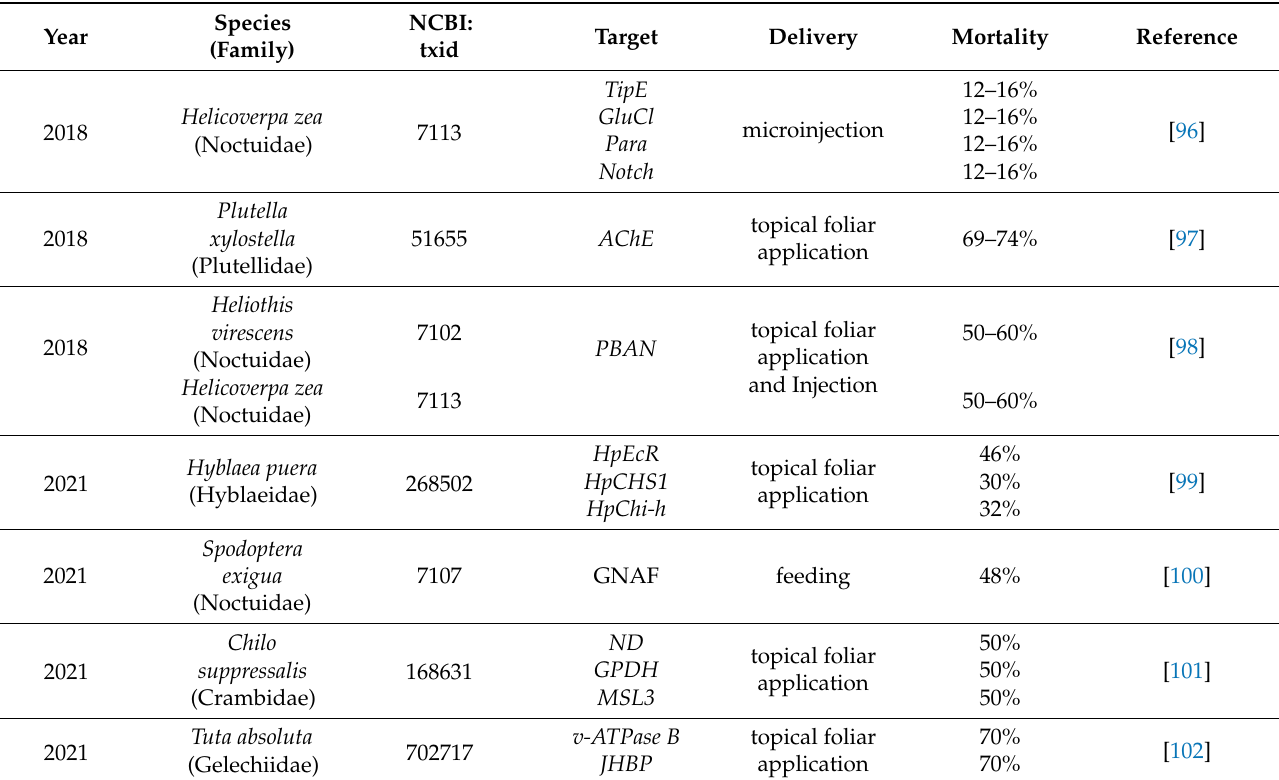
Table 2. Lepidopteran target genes validated for dsRNA silencing. The taxonomic positions of these genes’ corresponding species are depicted in Figure